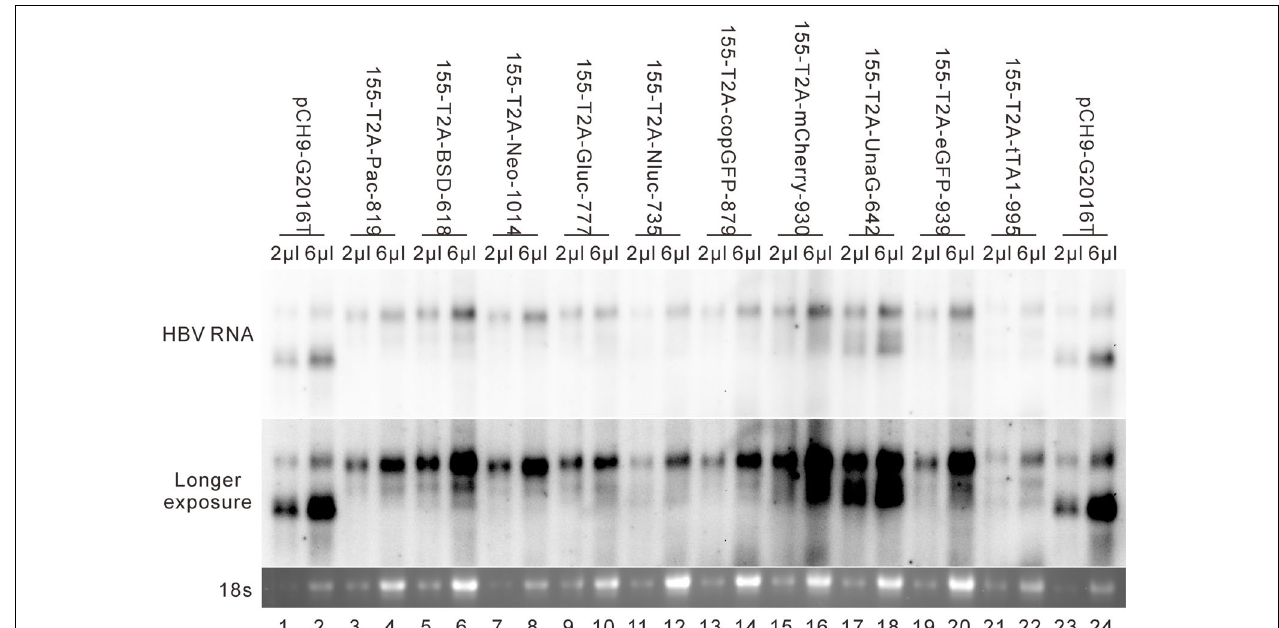
FIGURE 8 | RNA assay for the 155 recombinants. Representative Northern blotting is